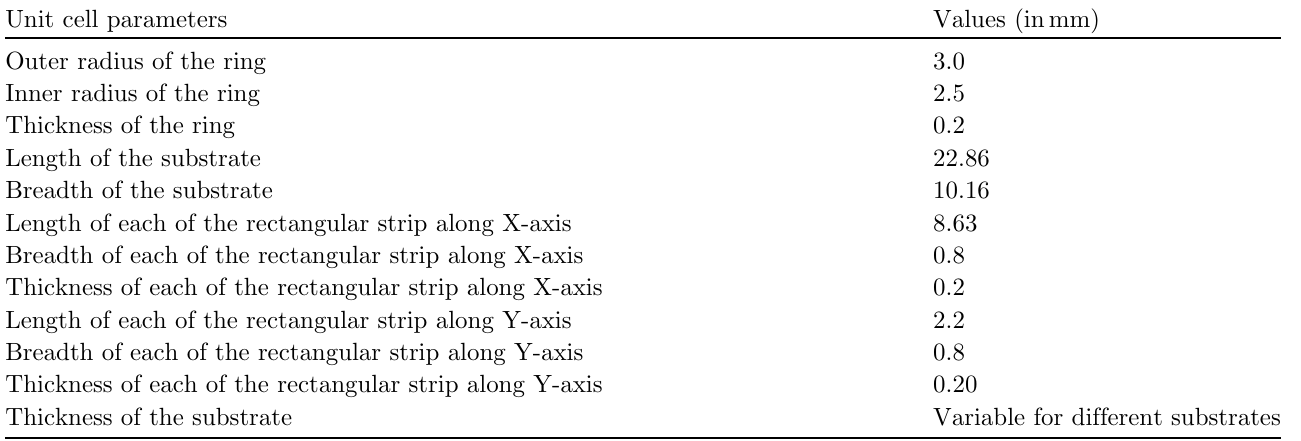
Table 2. Optimized MA